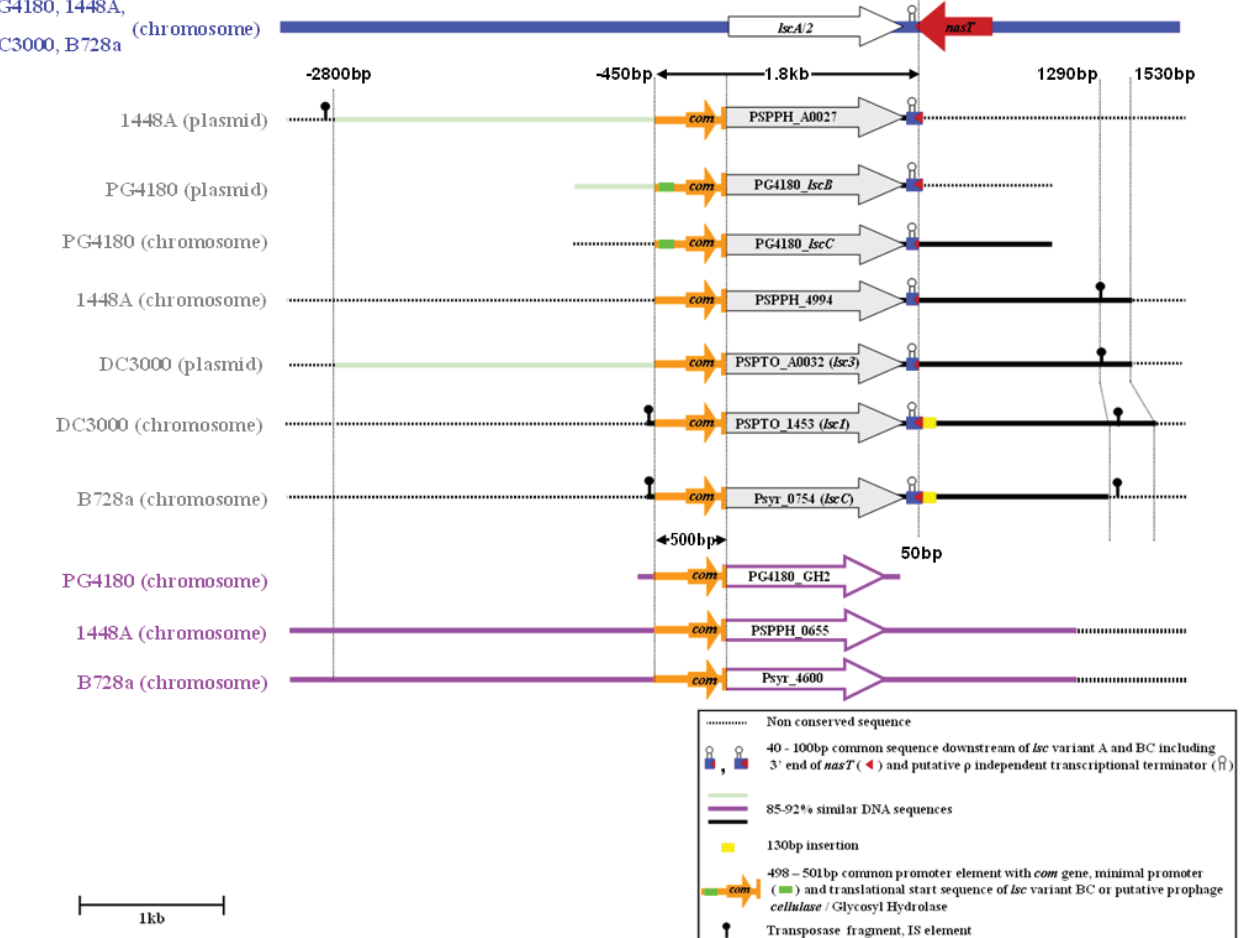
Figure 2. Genetic map showing variant BC alleles and their surrounding sequences in P. syringae pathovars represented by PG4180, 1448A, DC3000 and B728a. The 1.8-kb conserved nucleotide sequence contains 1.296-bp lsc coding sequence, 450 bp up-, and 49 – 51 bp downstream sequences of variant BC. The 500-bp conserved sequence represents the phage-associated promoter element (PAPE) linked with variant BC and the putative pro-phage-borne glycosyl hydrolase genes with 48 bp conserved N-termini of the coding sequences. PSPPH_0655 and Psyr_4600 are putative glycosyl hydrolase genes in 1448A and B728a, respectively. The PAPE contains the promoter of lsc and com genes. Variant BC comparison in their downstream sequences showed a different length of nucleotide conservation. The 25 – 100 bp sequences downstream of lscB/C stop codon show conservation with a 75-bp lscA downstream sequence and the 3’ end of the nasT gene. Variant A is depicted devoid of the 48-bp conserved sequence which is always associated with variant BC. Minus ( ‘−’ ) values depict upstream sequences to the translational start codon of lsc and positive values represent the nucleotide sequences downstream of lsc translational stop